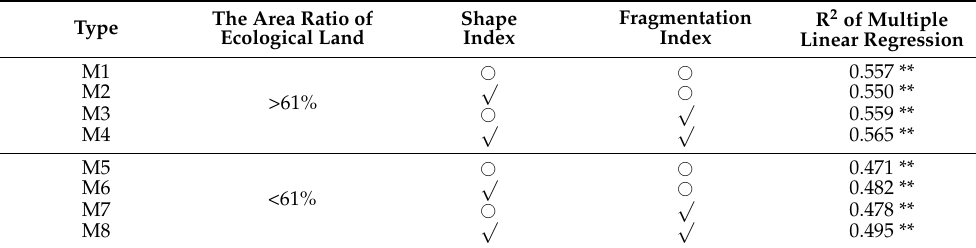
Table 1. Results of multiple linear regression analysis.